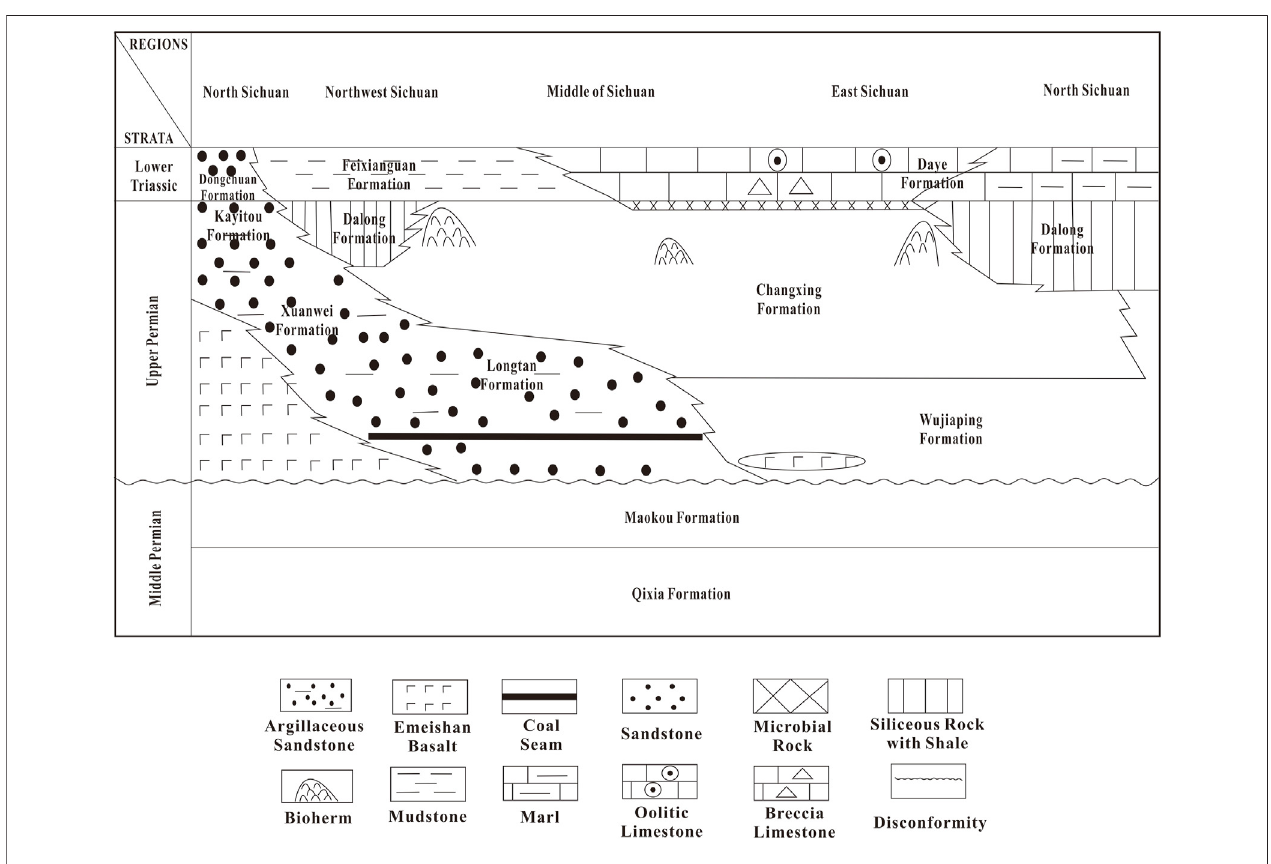
FIGURE 2 | Stratigraphic division of Sichuan Basin (modi fi ed after Yang, 2016).